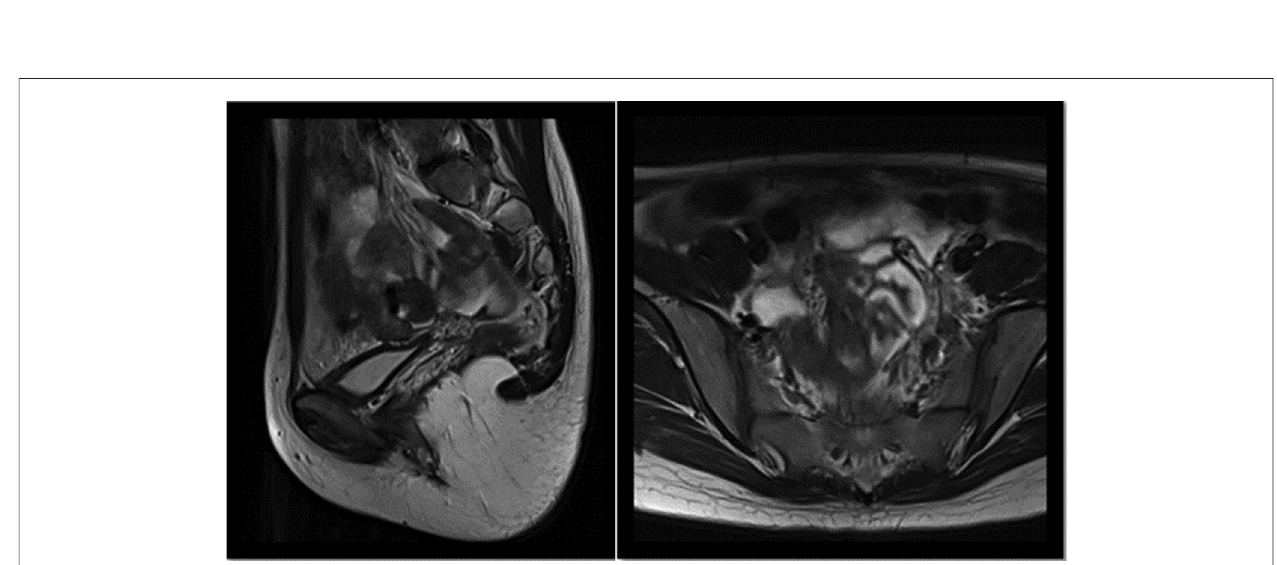
FIGURE 4 | Postoperative pelvic magnetic resonance images (1 month after